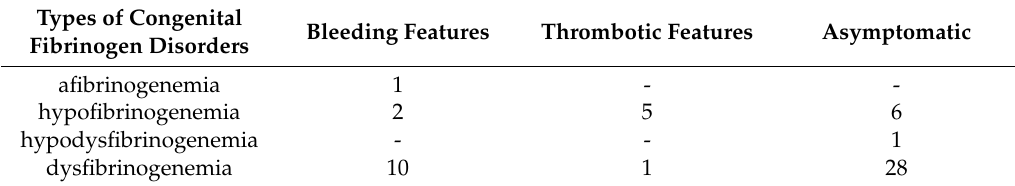
Table 1. Number and clinical features of patients with congenital fibrinogen disorders in The National Centre of Haemostasis and Thrombosis (data from the National registry of thrombophilic states, The Slovak